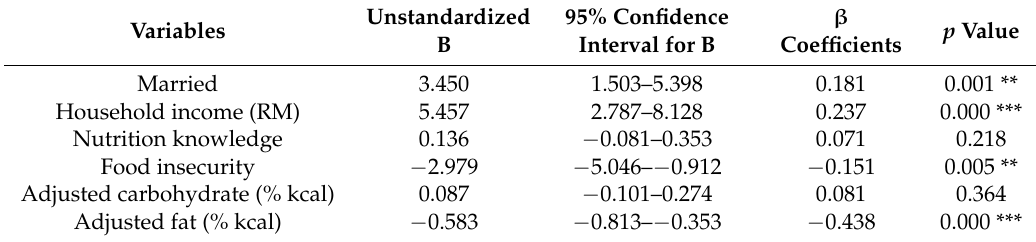
Table 6. Predictors of diet quality from the multiple linear regression model. Unstandardized 95% Confidence Variables B Interval for B